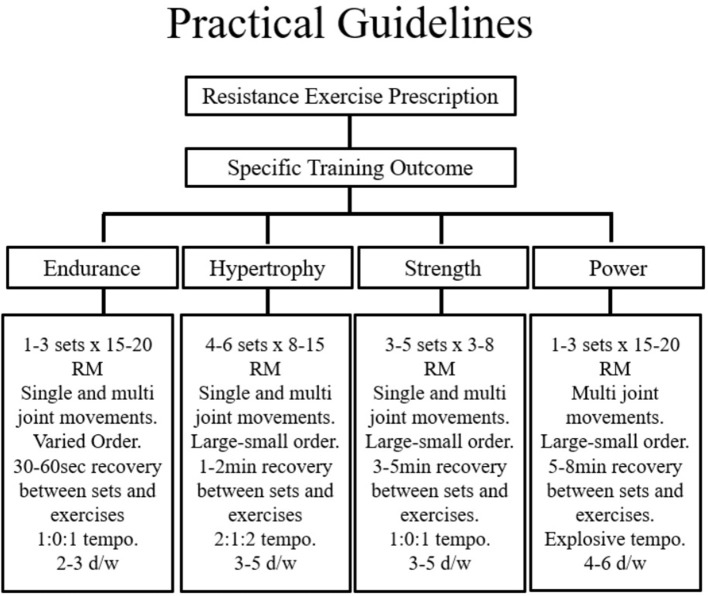
Proper programme design of resistance exercise for specific training outcomes incorporates the acute programme variables and key training principles. ECC, Eccentric; CON, Concentric; ISO, Isometric; Ex, exercise; Sec, seconds; RM, repetition maximum; Btn, Between; d/wk, Days per week. Figure adapted from Bird et al. [(104), Figure 2]. Springer Nature. Copyright © (Jan 1, 2005).